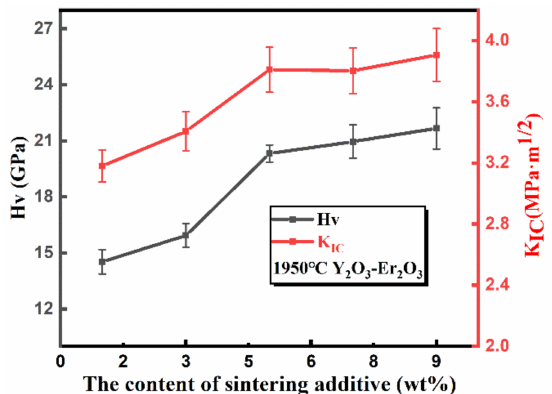
Figure 11. The hardness and fracture toughness of the sintered SiC samples at 1950 ◦ C as a function of the sintering additive